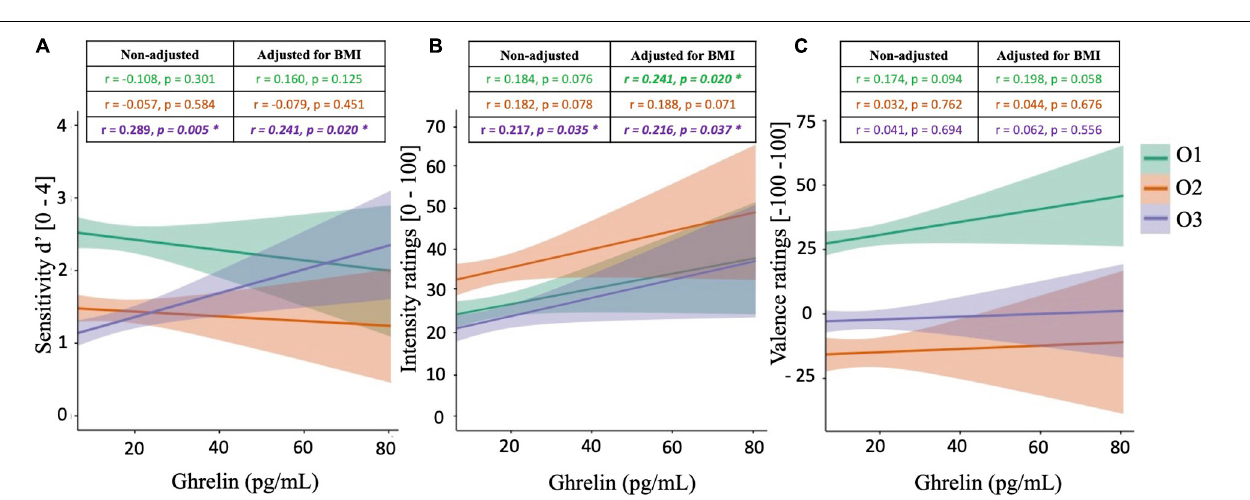
FIGURE 2 | Pearson’s correlations across three types of olfactory measures: supra-threshold sensitivity (d (cid:48) ), intensity ratings (IR) and valence ratings (VR) for the odorants O1 (A) , O2 (B) , and O3 (C) . The upper part of each figure illustrates the strength of the correlation via an elliptical shape, and the lower part shows the correlation coefficient value for each pair of sensory measures compared. Positive correlations are represented in a red gradient and negative correlation in a green gradient. O1: vanilla odour, O2: potato odour, O3: dairy odour. Significant results are represented by *.